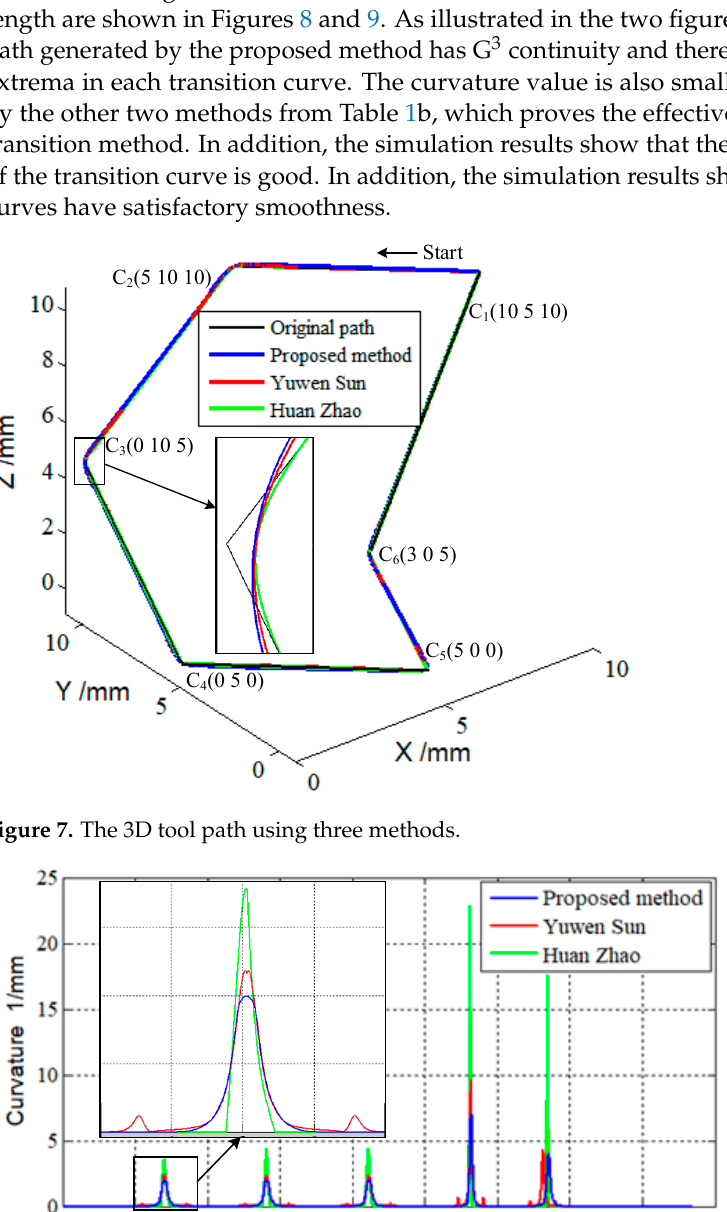
Figure 9. Curvature derivative profiles of 3D tool path. The profiles of the velocity are shown in Figure 10a. Since the transition curve is smoother, the proposed method can obtain the minimum machining time among the